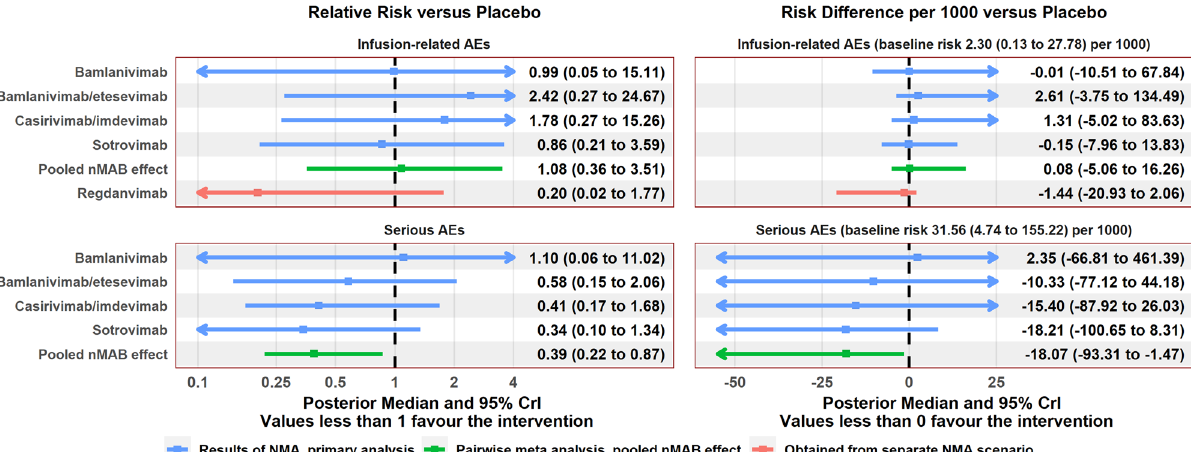
Figure 4. Summary of relative and absolute treatment effects for each treatment compared with SoC from the NMA, safety outcomes. Results obtained from Bayesian random-effects network meta-analysis model. Risk difference per 1000 patients represents the difference in number of events that would be expected to if 1000 patients with nMABs rather than SoC. Baseline risks for each event type were obtained by pooling event rates from the placebo arms across all included studies using a random-effects model. Treatment effects for regdanvimab were obtained from a separate scenario analysis. Regdanvimab is not included in the ‘pooled nMAB effect’ as no studies of regdanvimab meeting the inclusion criteria of the review were